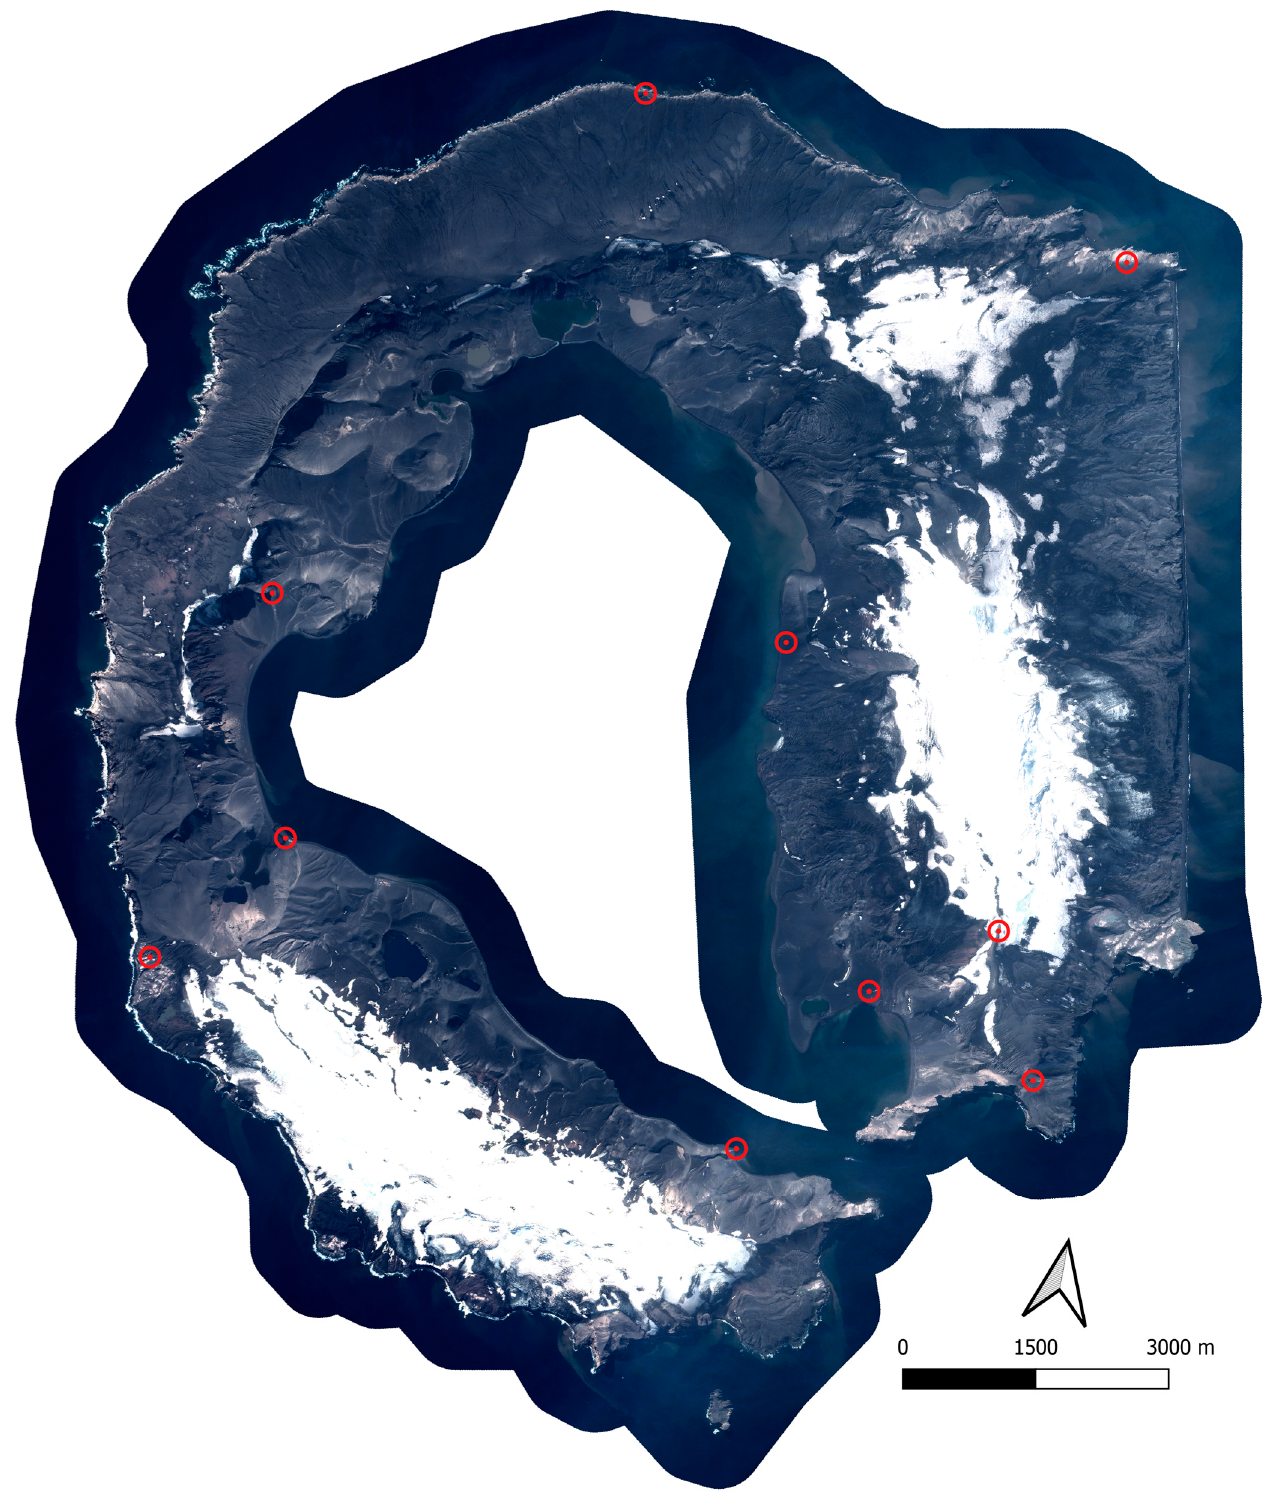
Figure 4. A colour, pan-sharpened orthographic mosaic of 2020 from Kompsat-3 imagery corrected with their rational polynomial coefficients and REMA digital elevation model. The locations of ten ground control points were applied in the production of the orthographic mosaics, as identified inside the red circles. Included material is ©KARI 2020, copyrighted distribution (SI Imaging Services, Republic of Korea), all rights reserved.